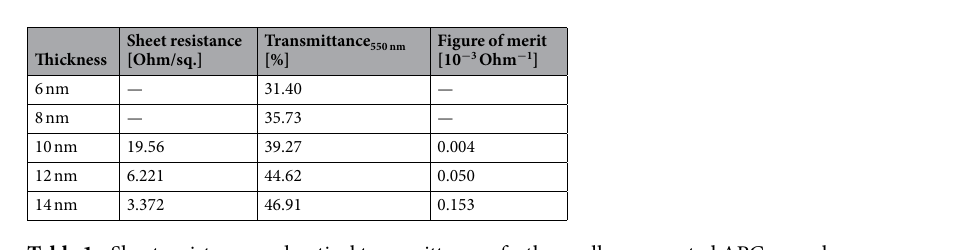
Table 1. Sheet resistance and optical transmittance of a thermally evaporated APC monolayer grown on a PET substrate as well as the calculated figure of merit